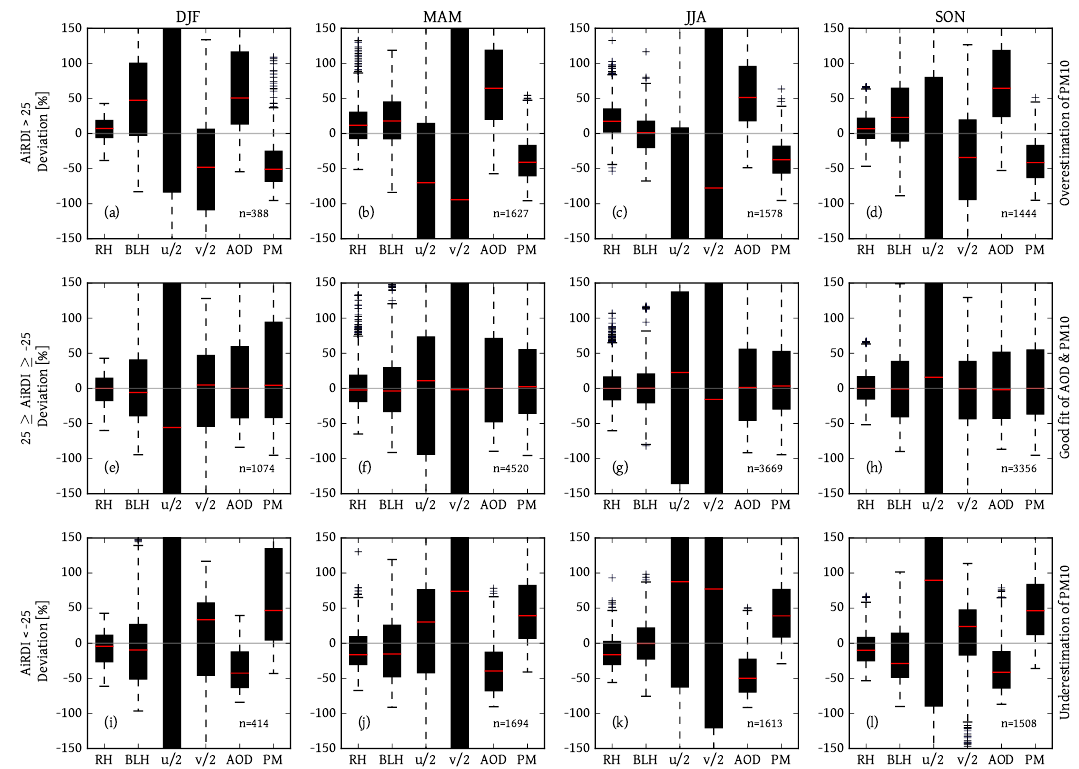
Figure 4. Determination of factors influencing AiRDI including relative humidity (RH), boundary layer height (BLH), wind velocity in u and v direction (u/2,v/2), aerosol optical depth (AOD) and PM10 (PM) . Data are split on a seasonal basis and divided in positive ( a – d ), negative values ( e – h ) and AiRDI values close to zero ( i – l ). Winter months are denoted as DJF, spring months as MAM, summer months as JJA, fall months as SON. Box plots show the relative deviation of each parameter observation to the seasonal mean. Deviations for u and v were multiplied by a factor of 0.5 to prevent a distortion of the y-axes. The box plots extend from the lower to the upper quartile value, with a red line at the median. Whiskers show the range with outliers marked as short, horizontal black lines. The number of observations for each class is denoted as